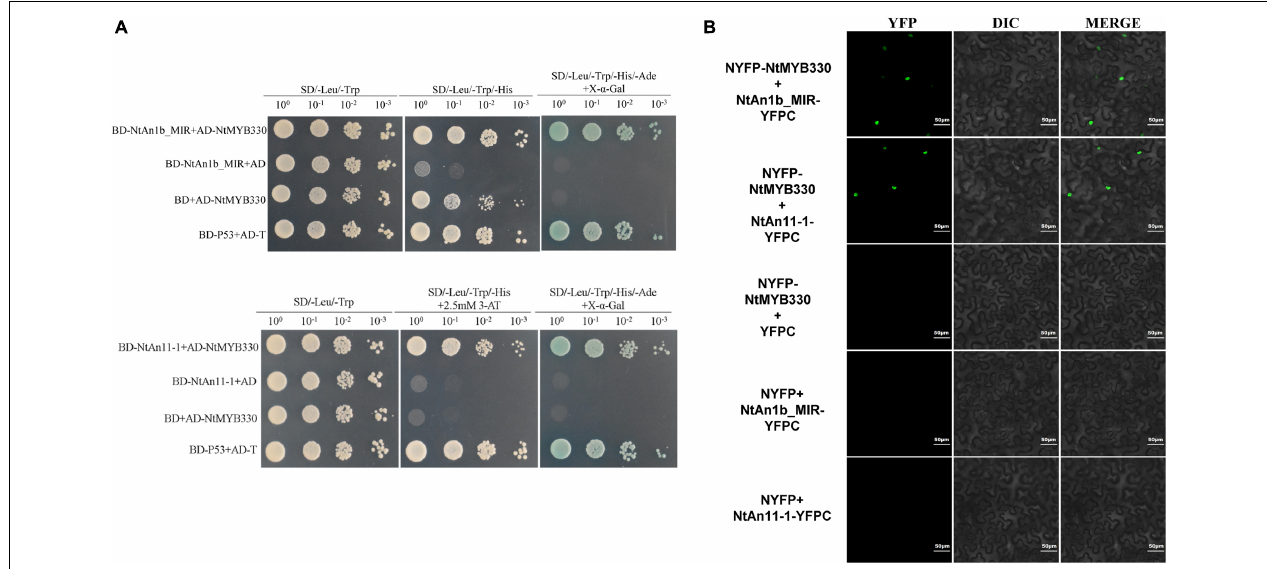
FIGURE 5 | NtMYB330 interacts with NtAn1b_MIR and NtAn11-1. (A) Y2H assays reveal the interactions between NtMYB330 and NtAn1b_MIR, and between NtMYB330 and NtAn11-1. The coding sequence of the MYB-interacting region (MIR) of NtAn1b and the full-length coding sequence of NtAn11-1 were cloned into pGBKT7 to make fusion constructs BD-NtAn1b_MIR and BD-An11-1, respectively, and were co-transformed with pAD-NtMYB330. The interactions were indicated by yeast growth and X- α -Gal staining. Yeasts grown on medium with double (SD/-Leu/-Trp), triple (SD/-Leu/-Trp/-His) or quadruple (SD/-Leu/-Trp/-His/-Ade) selection were indicated. (B) BiFC assay shows the localization of NtMYB330–NtAn1b_MIR or NtMYB330-NtAn11-1 complex in epidermal cells of N. benthamiana . The full-length cDNA of NtMYB330 was fused to N-terminal half of the yellow fluorescent protein (YFP), while cDNA of NtAn1b_MIR (aa 1–195) or the full-length cDNA of NtAn11-1 was fused to C-terminal half of YFP. NYFP-NtMYB330 plus YFPC, NYFP plus NtAn1b_MIR-YFPC, and NYFP plus NtAn11-1-YFPC were used as the controls. Yellow signals indicate the positive interactions. Scale bar = 50 µ m. Experiment was repeated three times, representative data from one experimental replicate presented